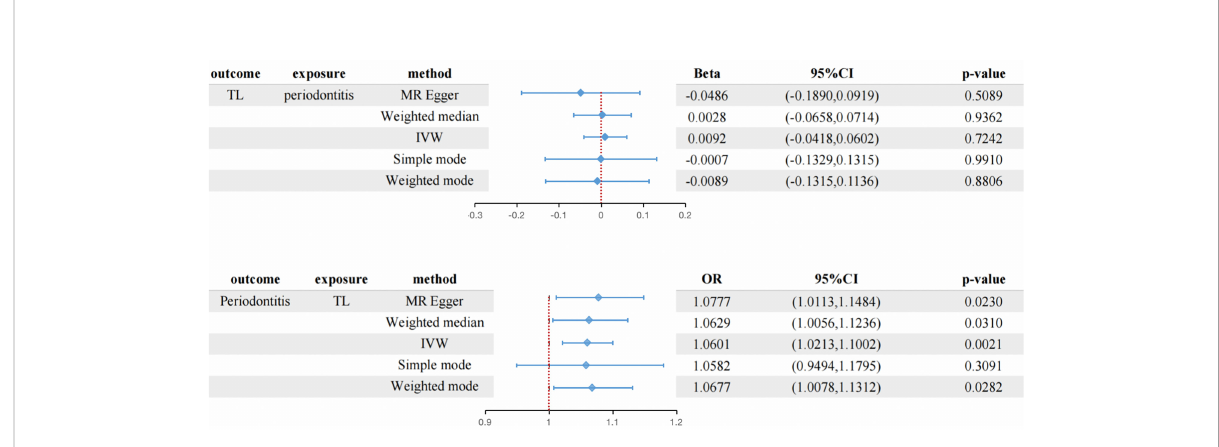
FIGURE 2 The connection between genetically instrumented periodontitis and TL, and vice versa is estimated using MR(the table at the bottom shows the OR of TL shortening to periodontitis) CI, con fi dence interval; IVW, inverse variance-weighted; MR, Mendelian randomization; OR, odds